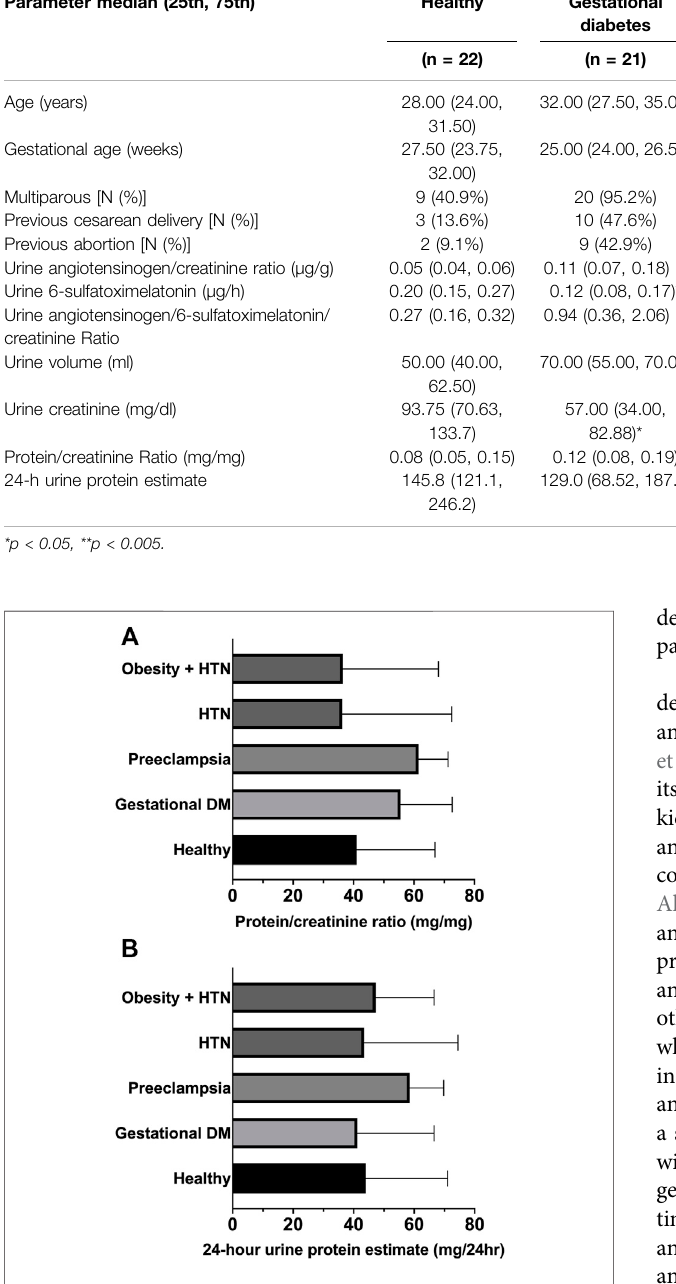
FIGURE 2 | (A) Protein/creatinine ratio. (B) 24-h urine protein estimate. Graphs are ranks plots with bars of median with interquartile range; Kruskal – Wallis test, no signi fi cant differences between